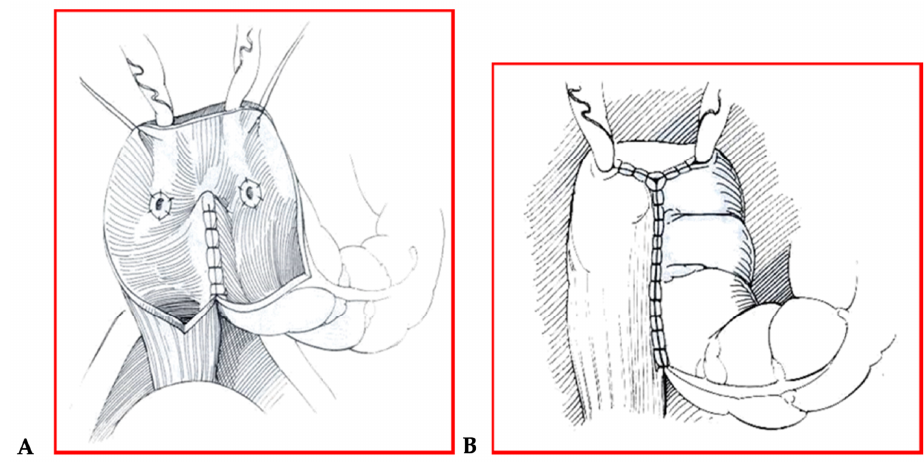
Figure 1. ( A , B ) Mainz pouch II technique.